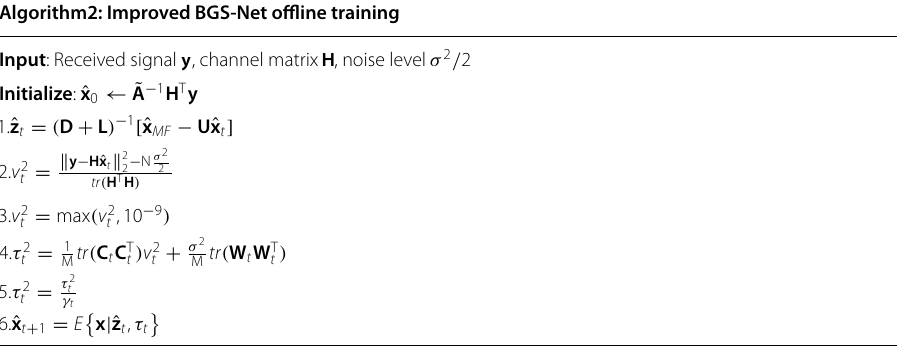
Algorithm2: Improved BGS‑Net offline